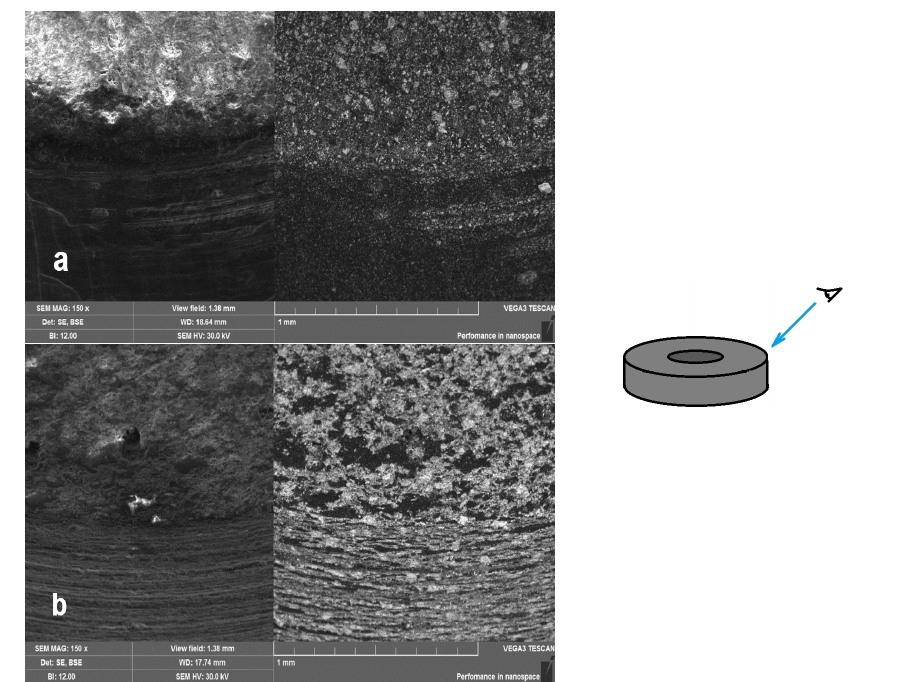
Figure 5. Surface morphology of composite samples with NiCu-Y hexaferrite powder; ( a )—sample N1, ( b )—sample N2. N1, ( b )—sample N2.